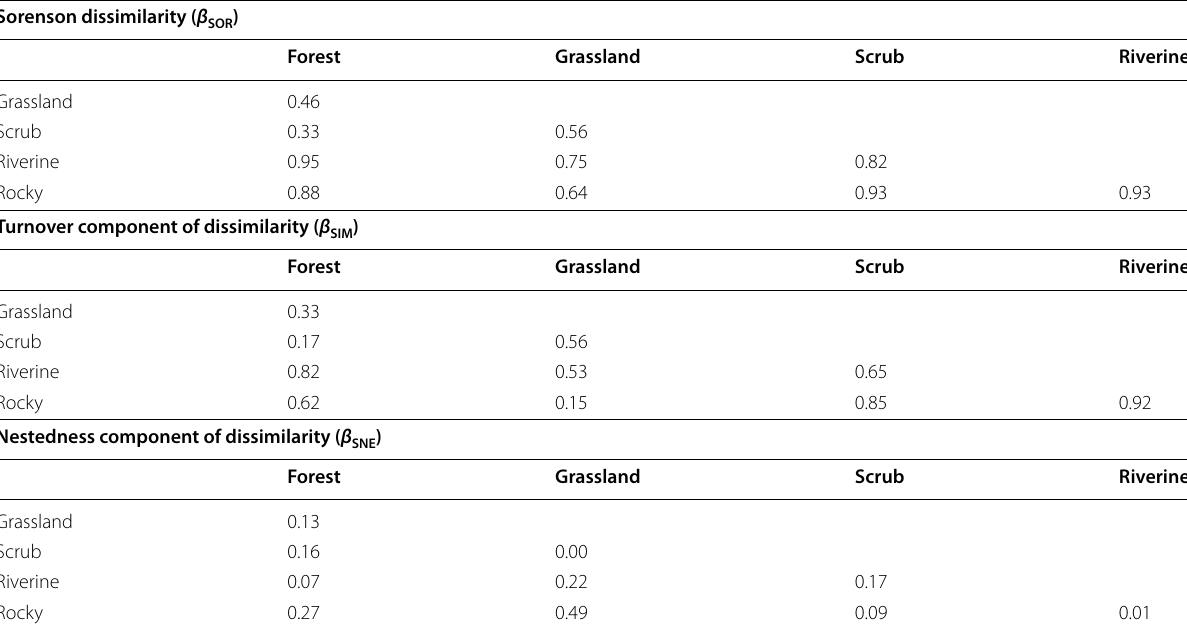
) along with the turnover ( β SOR